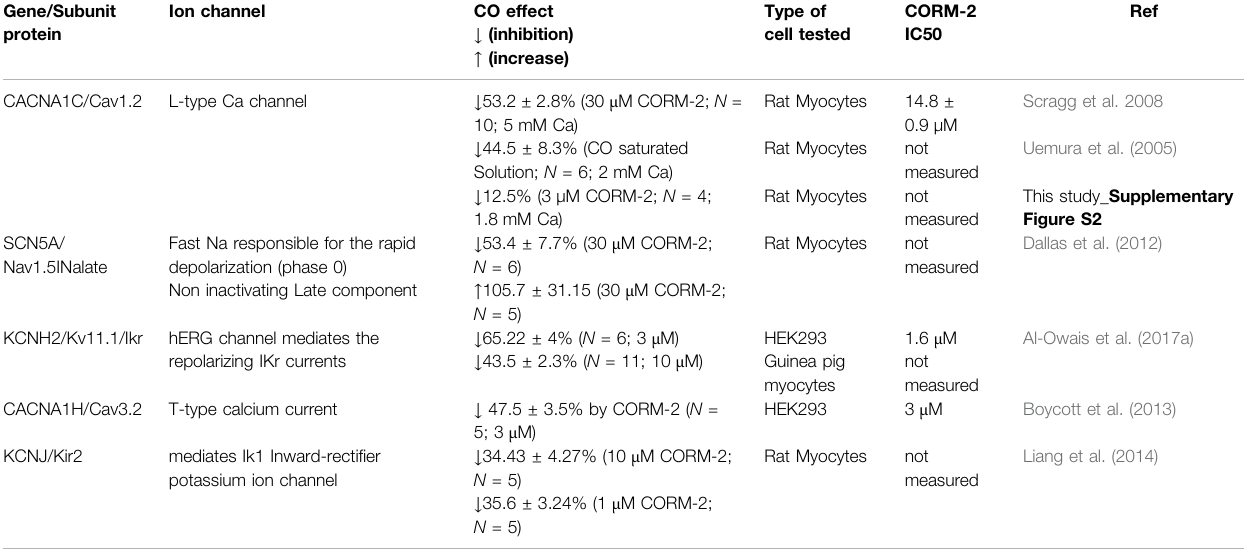
TABLE 2 | summary changes in maximal ionic currents from literature induced via CO. Gene/Subunit